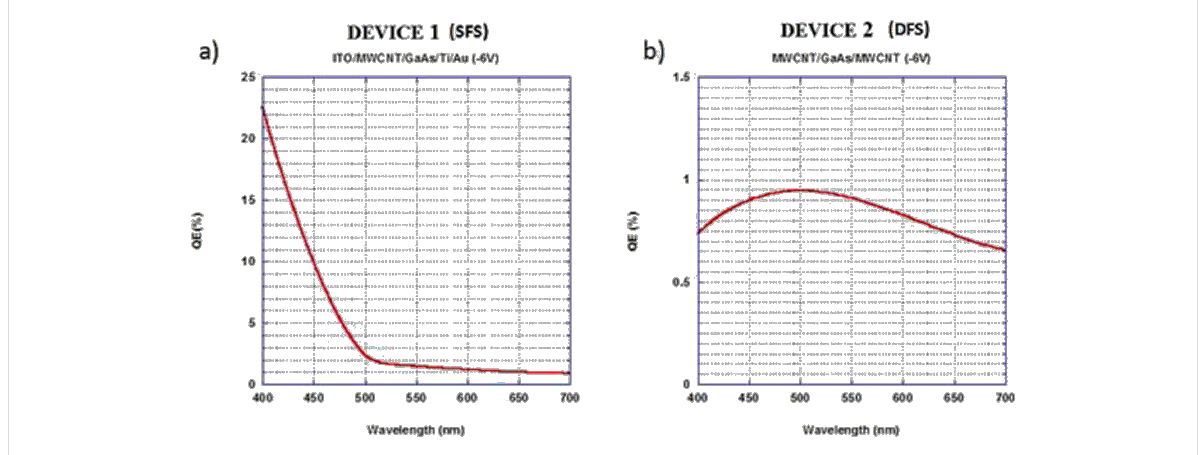
Figure 5: Absolute quantum efficiency trend in the visible light range, calculated at a bias voltage of − 6 V for the devices SFS a) and DFS b).